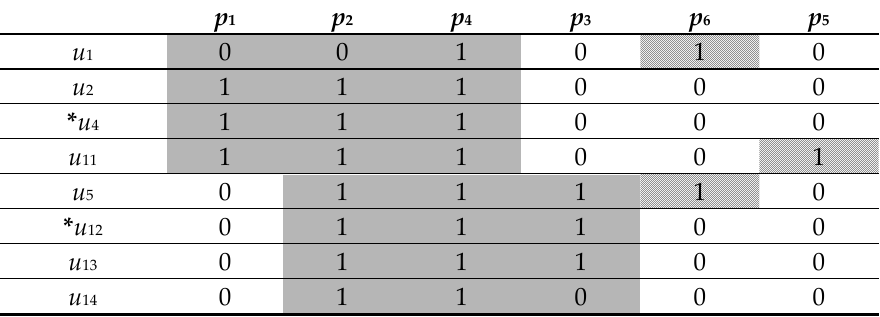
Table 5. User cluster CU 2 .